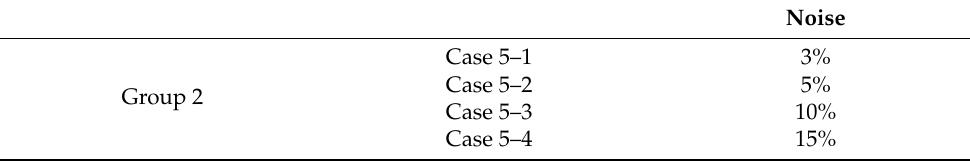
Table 5. The experiment setting in the second group of experiments.